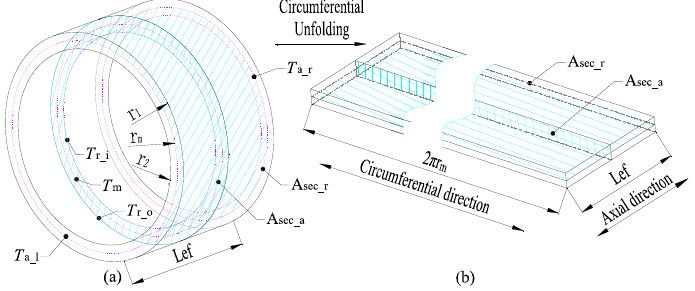
Figure 1. Component definition ( a ) hollow cylinder, ( b ) unfolded brick.